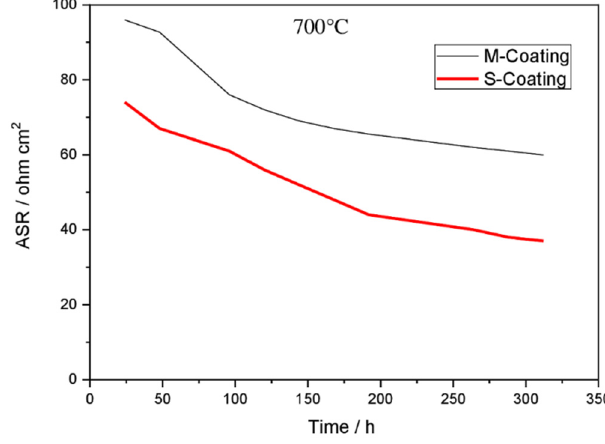
Figure 7. The ASR behavior of the thin-film perovskite coatings grown on the surface of M-coating and S-coating samples at 700 °C in air.